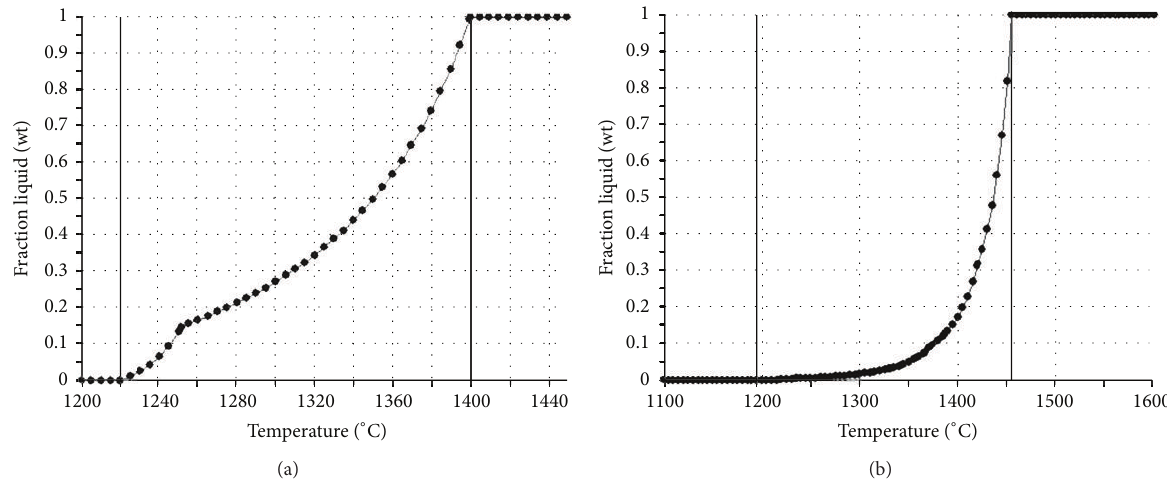
Figure 6: Liquid fraction profile for chemical composition of (a) AISI D2 tool steel and (b) AISI 304 stainless steel obtained from JMatPro simulation.